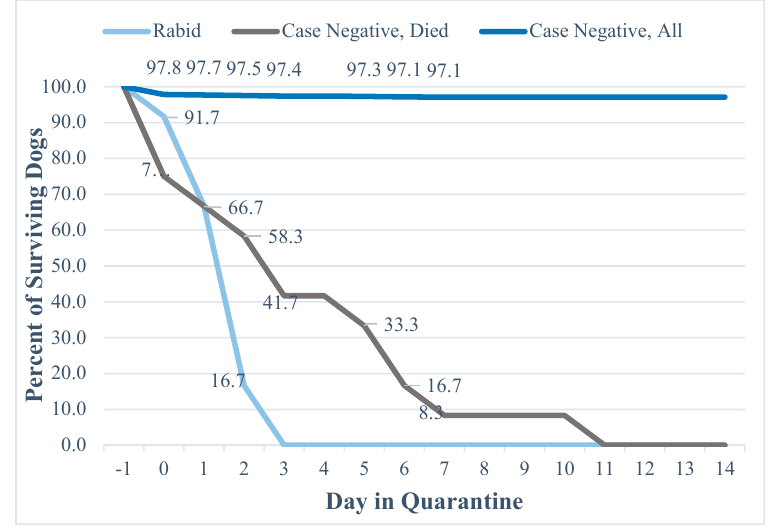
Figure 3. Proportion of surviving dogs during a 14-day rabies quarantine.